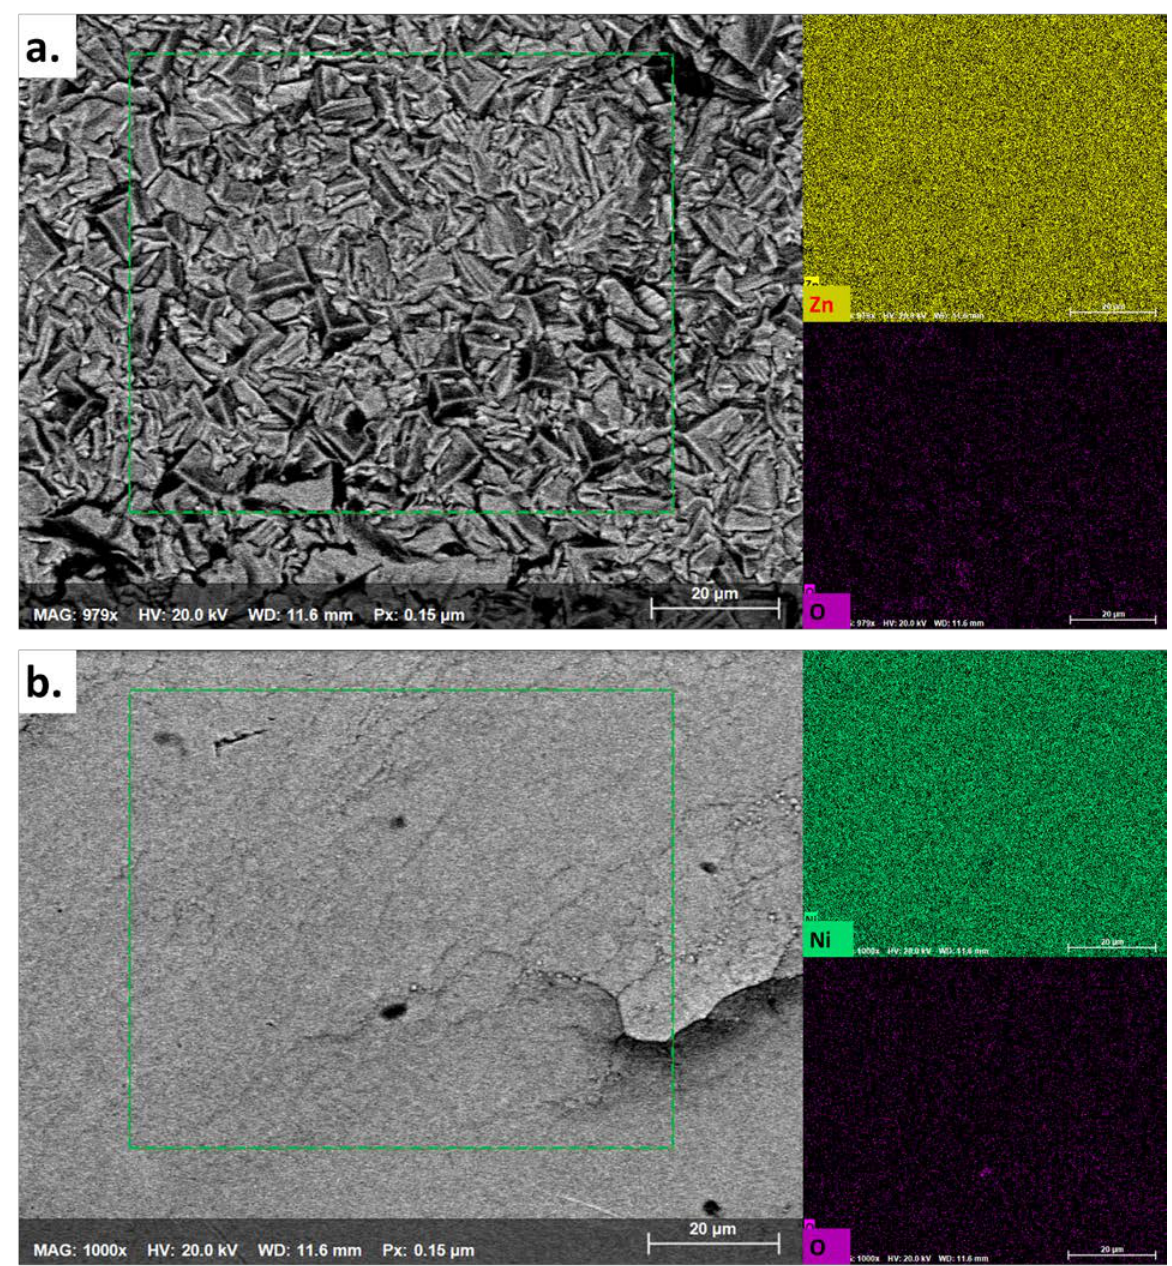
Figure 4. Surface morphology of the ( a ) pure Zn and ( b ) Ni coating showing the elemental distribution of Zn, and Ni in the coating, respectively. The ‘O’ maps are shown to highlight the presence of any oxide species on the surface.